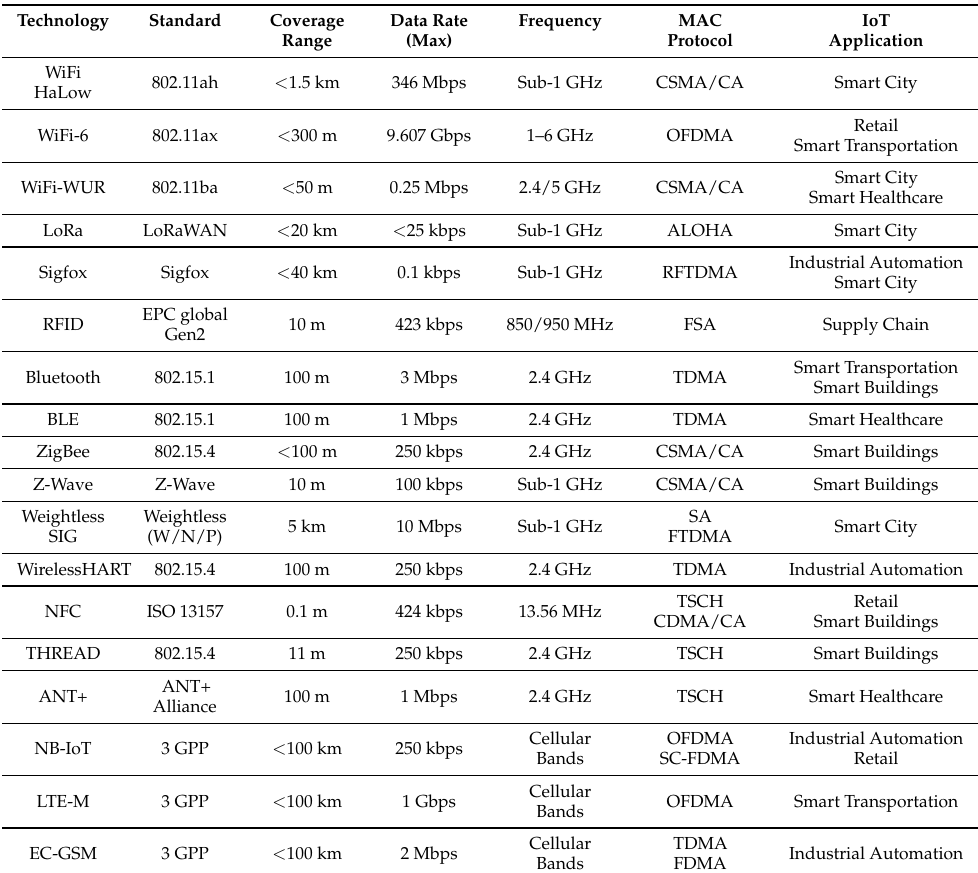
Table 2. Overview of potential technologies for